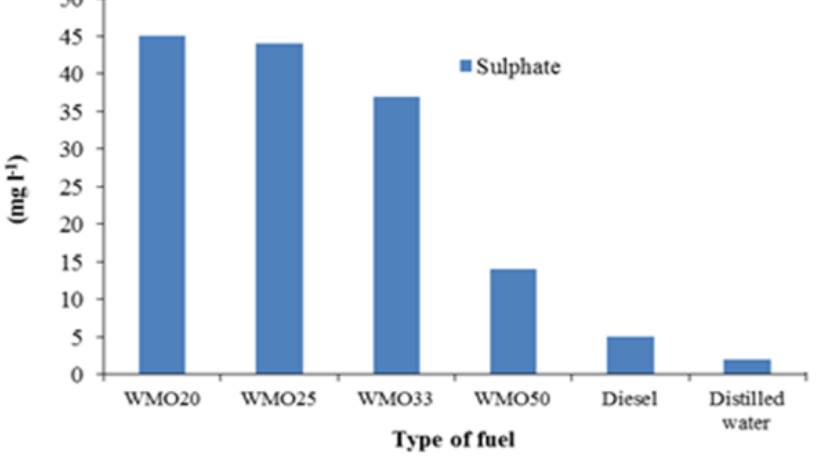
Figure 7. Sulphate fraction in the solution during the flue gas purification for different fuel types.